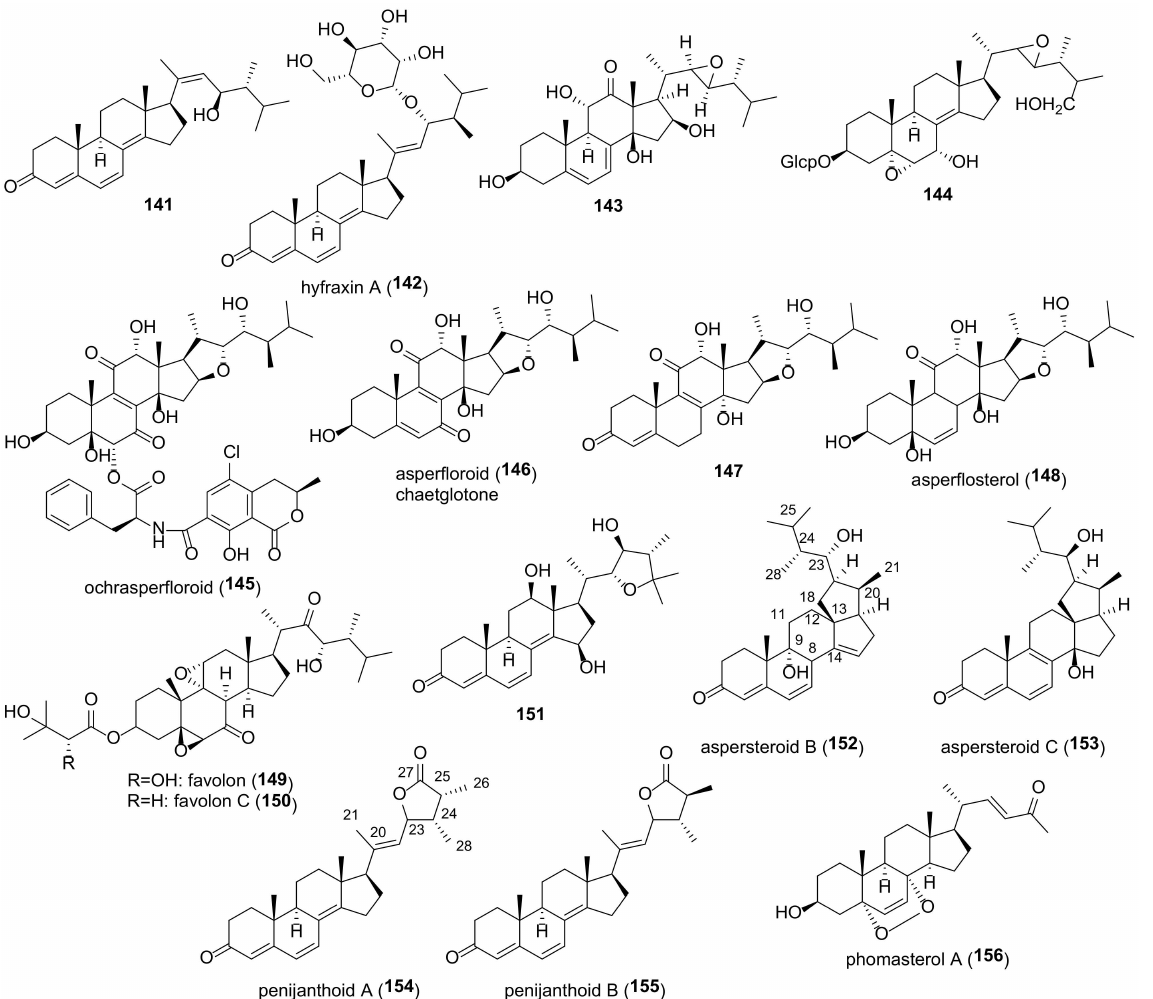
Figure 16. Structures of steroids with a transformed side